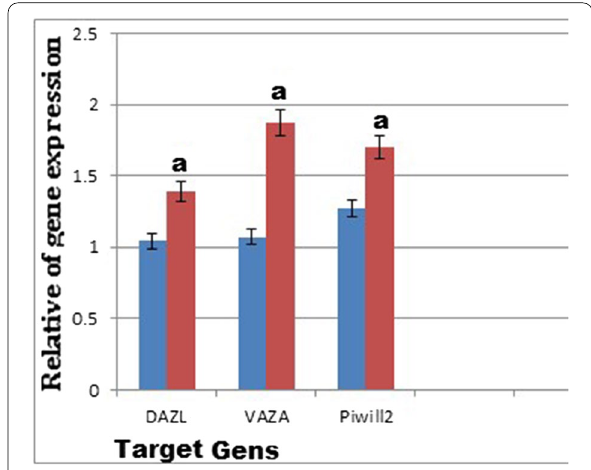
Fig. 4 Comparison of specific spermatogonia gene expression, in seeded SSCs on Silk scaffolds . Ratio gene expression of DAZL, VASA, and Piwil2 in SSCs grown on scaffolds compared to control . Data are shown as mean SEM from three independent experiments. a: ± significant increase with the control group